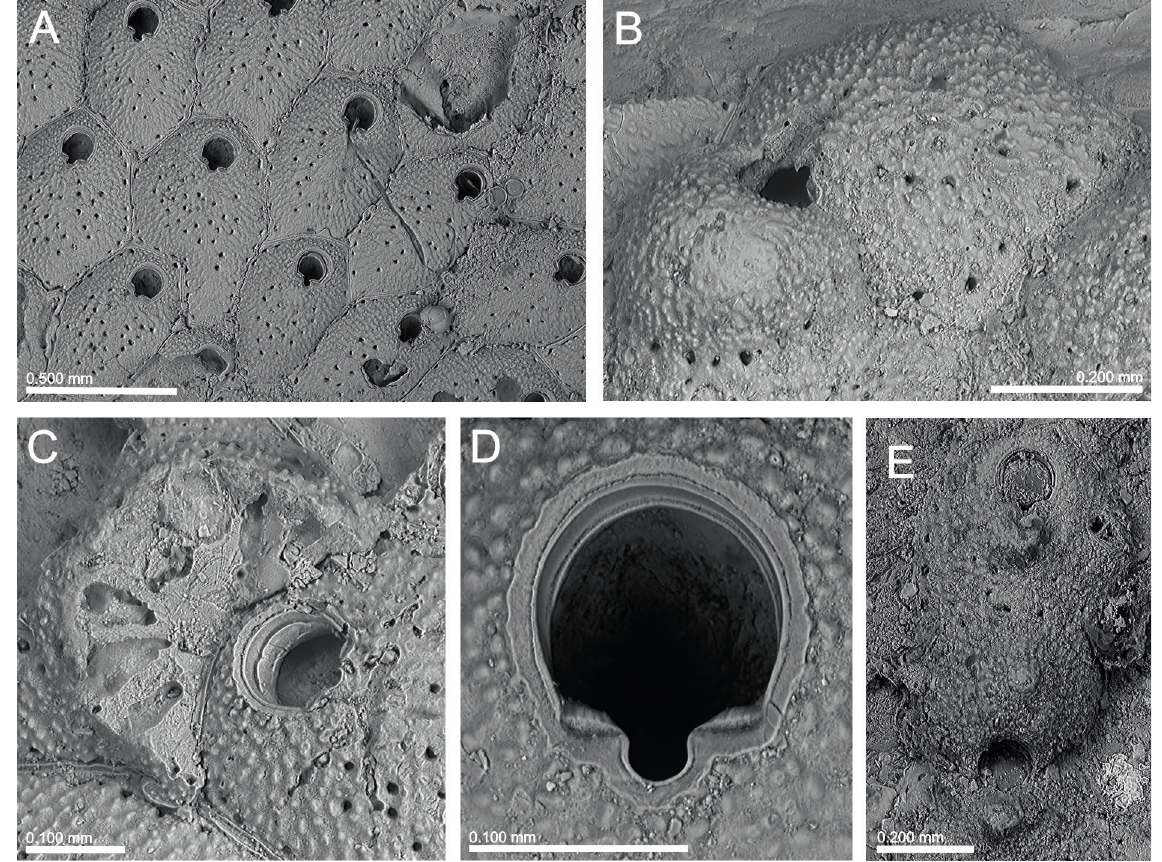
Fig. 4. Escharina alderi (Busk, 1856). A . Group of autozooids (NHMUK 1911.10.1.1197, type of Alysidota alderi Busk, 1856). B . Same, ovicellate zooid; note the distal marginal pores in the ovicell. C . Same, detail of a broken ovicell. D . Same, primary orifice. E . Ovicellate zooid and one adventitious avicularium in a uniserial colony (NHMUK 1899.7.1.2145, paratype of Alysidota alderi Busk,